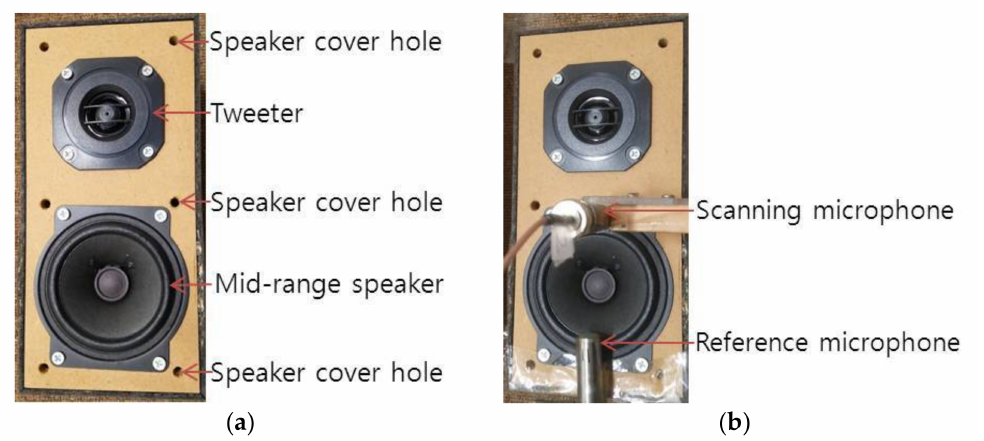
Figure 3. Loudspeaker and microphones used for noise measurement: ( a ) Loudspeaker; ( b ) Loudspeaker with reference and scanning microphones.